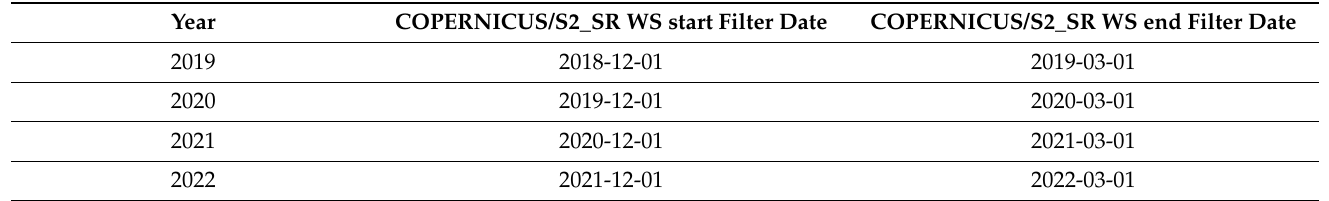
Table 13. Earth Engine COPERNICUS/S2_SR WS time series filter date.